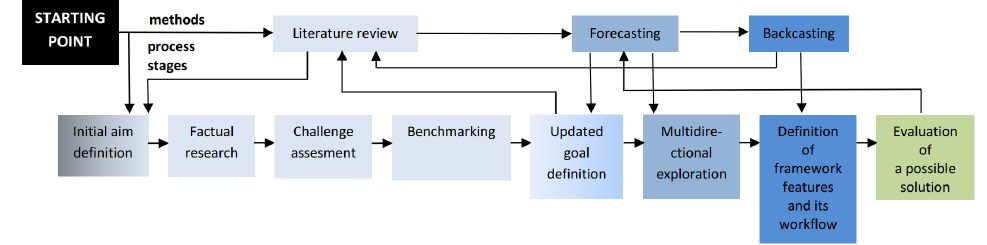
Figure 2. Methodologies applied during the design process.